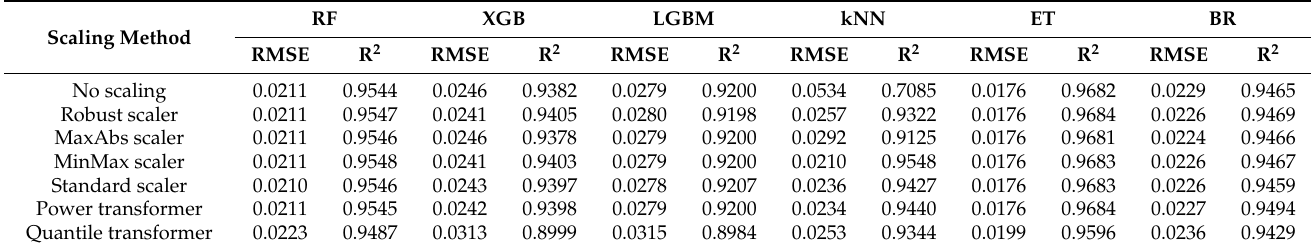
Table 5. The effect of different scalers on NO 3 prediction in the River Enborne. Scaling